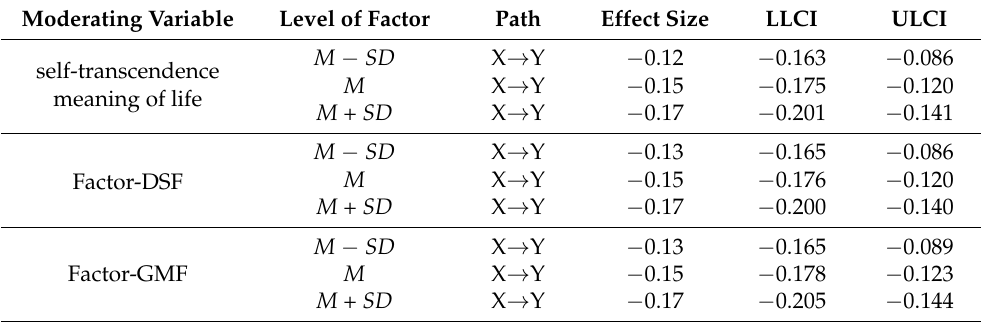
Table 4. The moderating effect of self-transcendent meaning of life, factor-DSF, and factor-GMF on path.